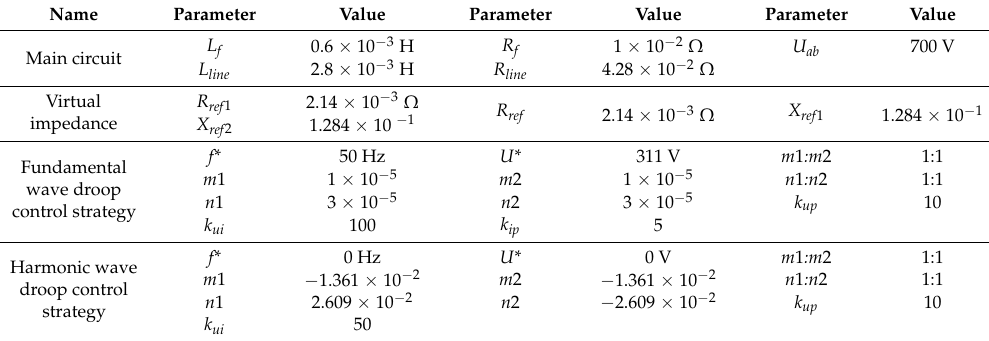
Table 1. Information of simulation parameters.